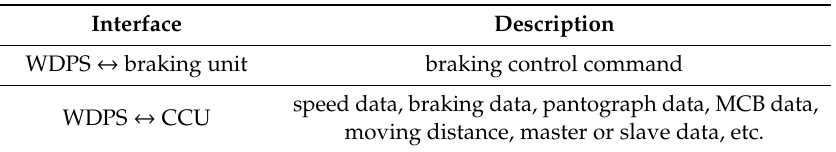
Table 1. Control data for heavy haul freight.